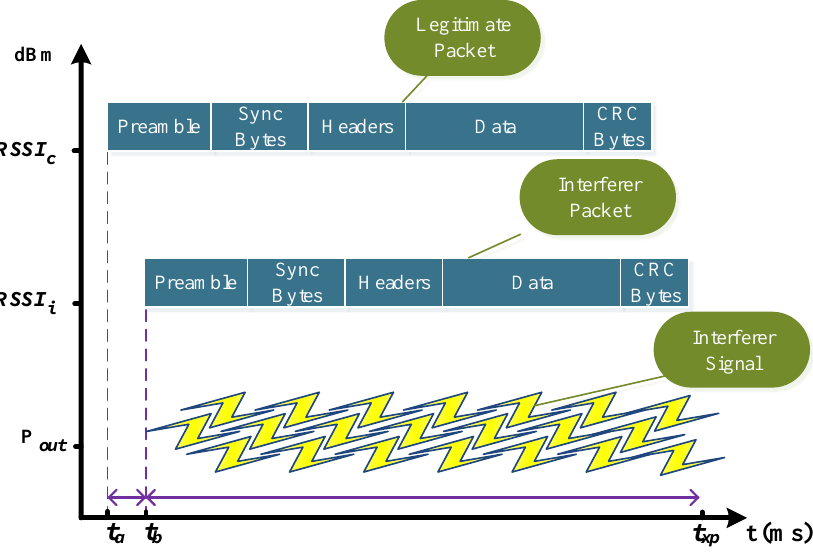
Figure 2. Description of the collision scenario for the different experiments. The difference between t a and t b divides the analysis of the collision and help to understand the behavior of the transmission under jamming attacks. We also show that the jamming strategy can be carried out using a data frame or noise